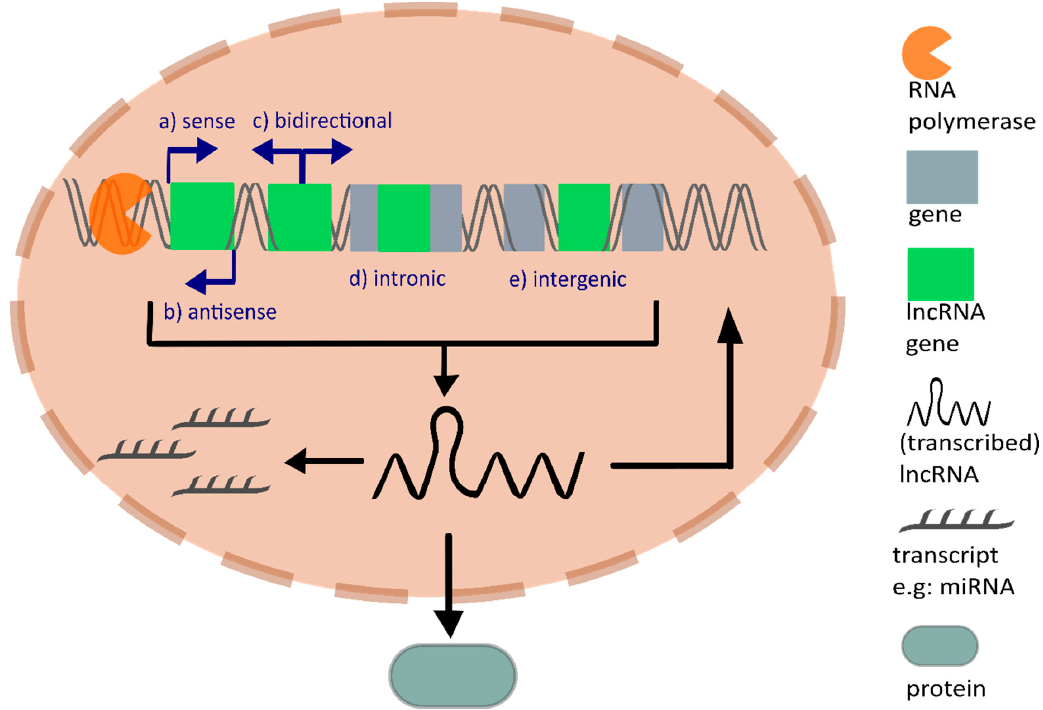
Figure 1. Schematic representation of long non-coding RNA (lncRNA) biogenesis and lncRNA function. According to their genomic localization, lncRNAs are divided into sense, anti-sense, bidirectional, intronic, or intergenic lncRNAs. They are transcribed by RNA polymerases and are often spliced, 5 ′ capped, and polyadenylated. Some lncRNAs are further translated into proteins, most of them function immediately after transcription on genome regulation or as binding partners for molecules inside (e.g., transcripts such as microRNAs (miRNAs)) or outside the nucleus (e.g., proteins).